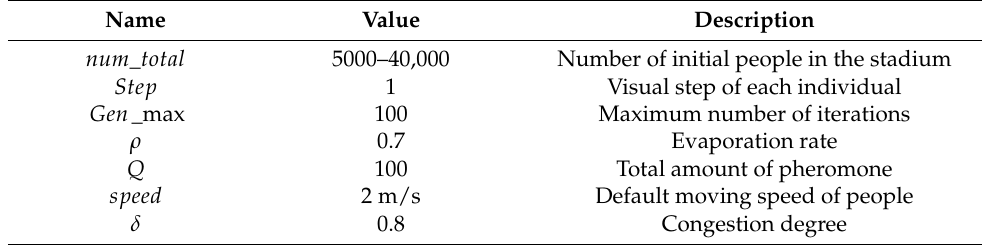
Table 1. Initial values of AFSAP algorithm parameters.